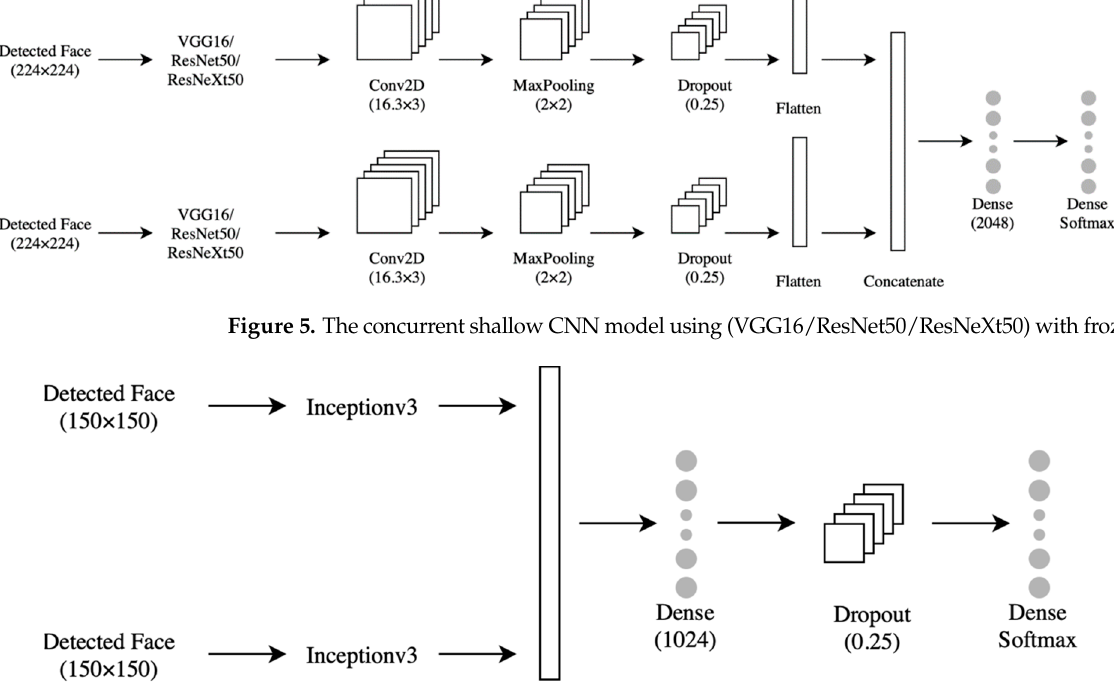
Figure 6. The concurrent shallow CNN model using InceptionV3 with frozen layers.